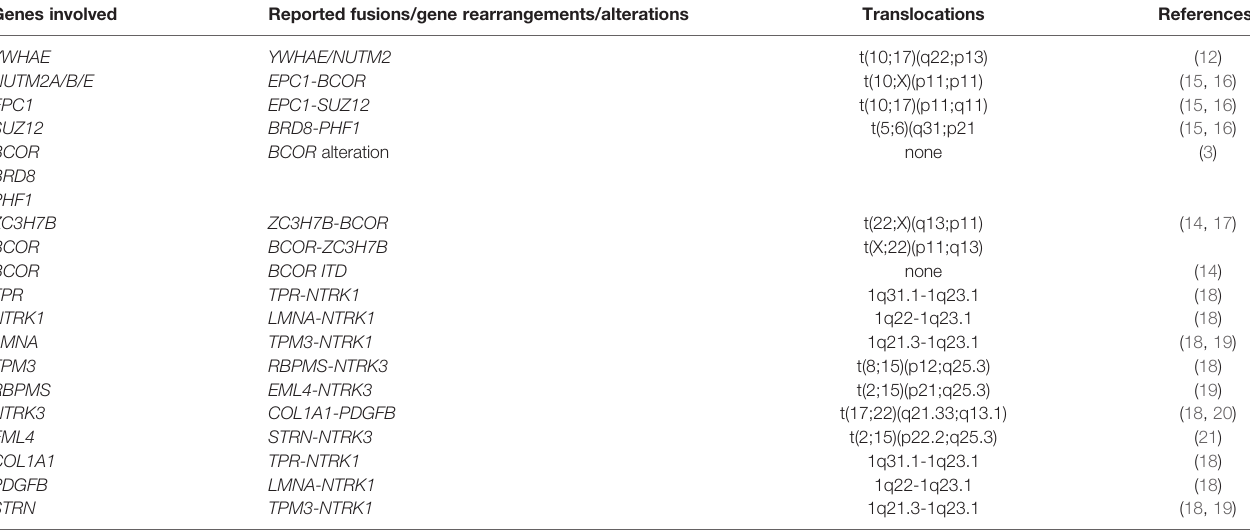
TABLE 1 | HG-ESSs with molecular alterations frequently